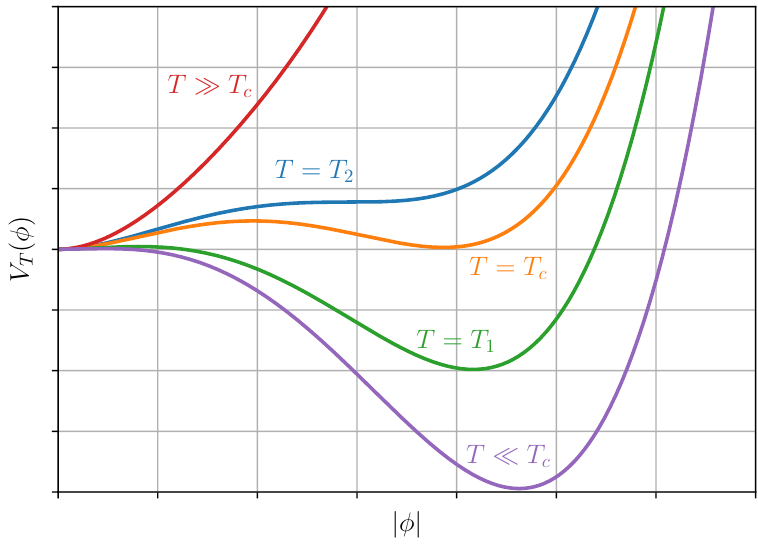
Figure 1 . The thermal potential for varying temperatures. T (cid:29) T c is the limit in which the potential is symmetric around φ = 0 , T = T 2 is the temperature below which a second minimum appears, T c is the critical temperature at which there are degenerate minima, and T = T 1 is where the first minimum at the origin disappears and the second minimum becomes the only equilibrium